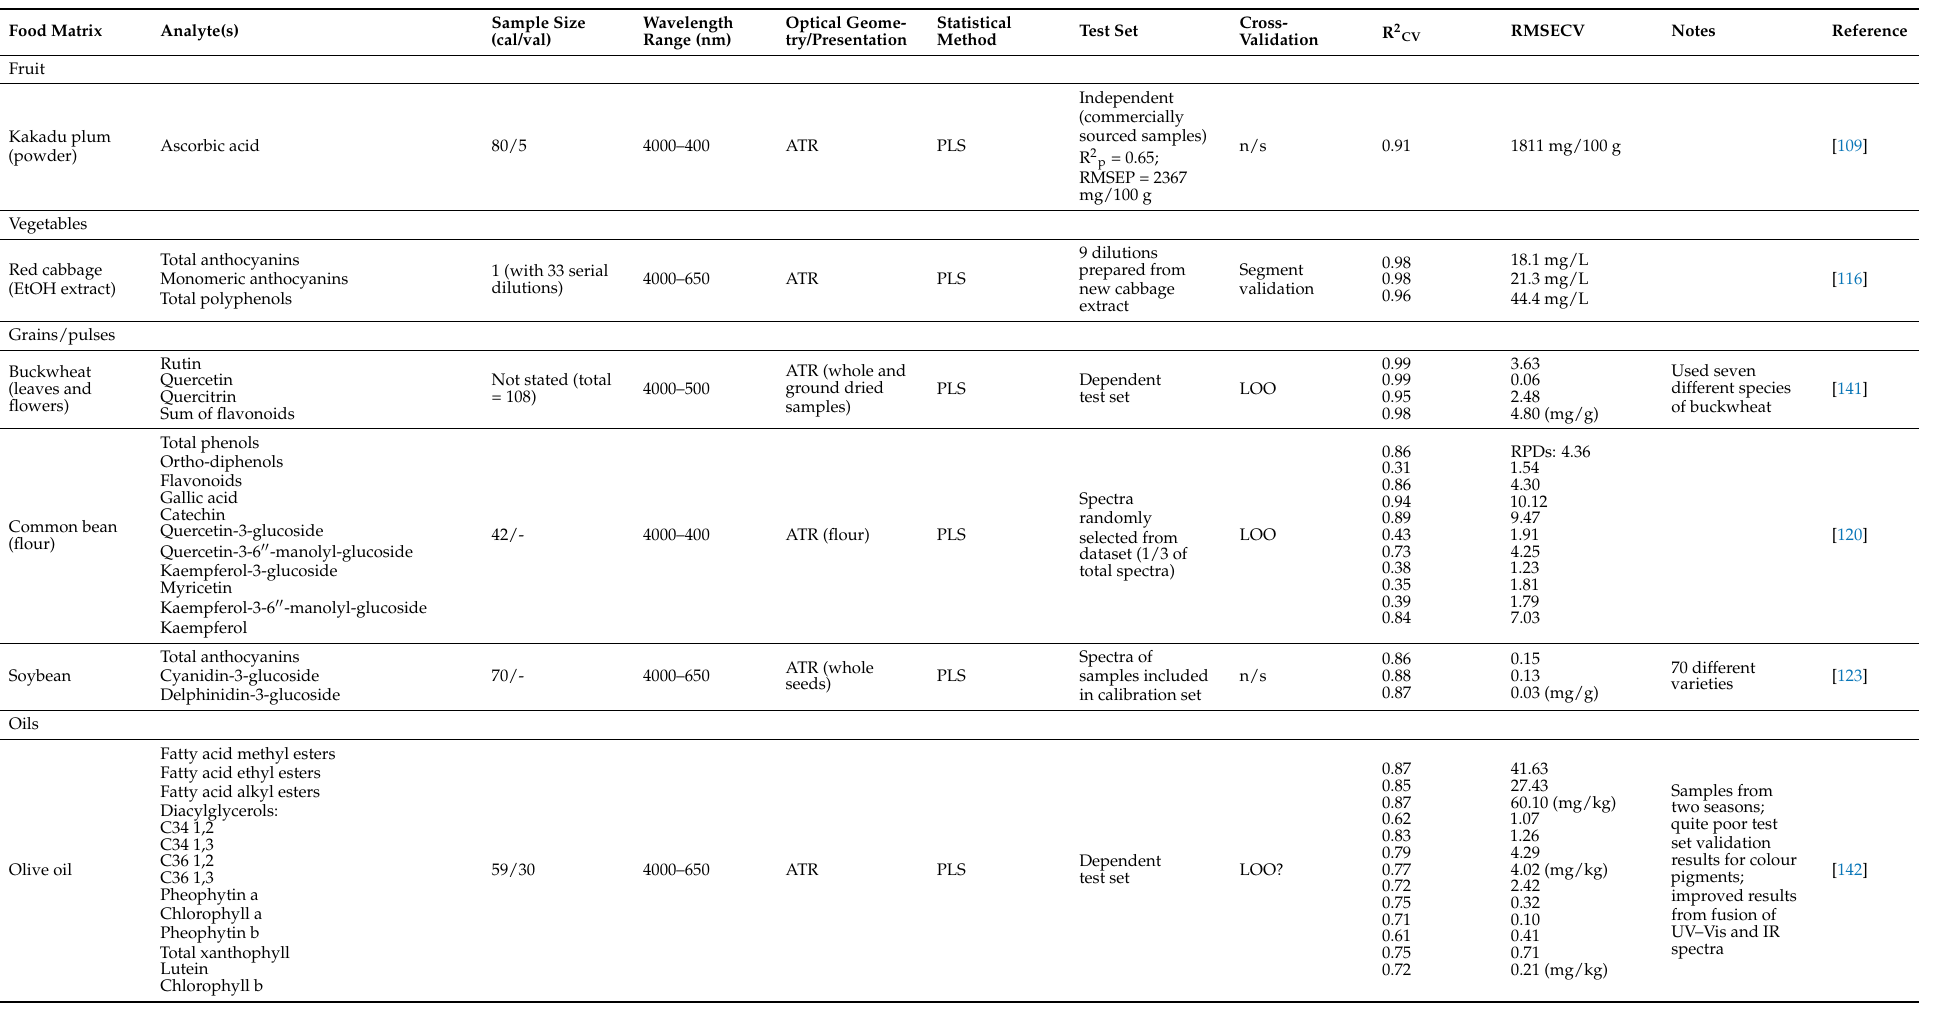
Table 3. Studies reporting the use of mid-infrared spectroscopy for the quantification of bioactive compounds in food products